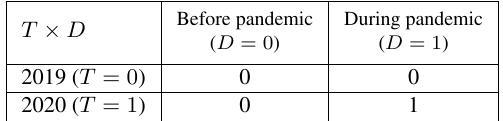
Table 1. DID configuration.